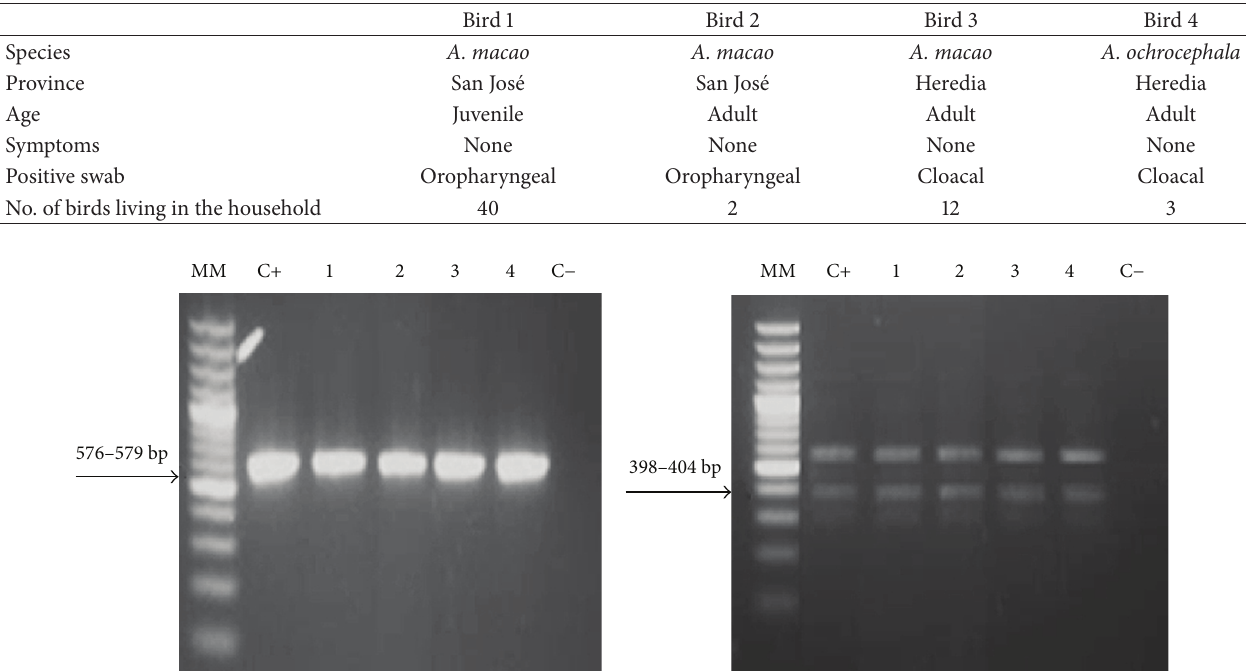
Table 3: Description of birds positive to C. psittaci.